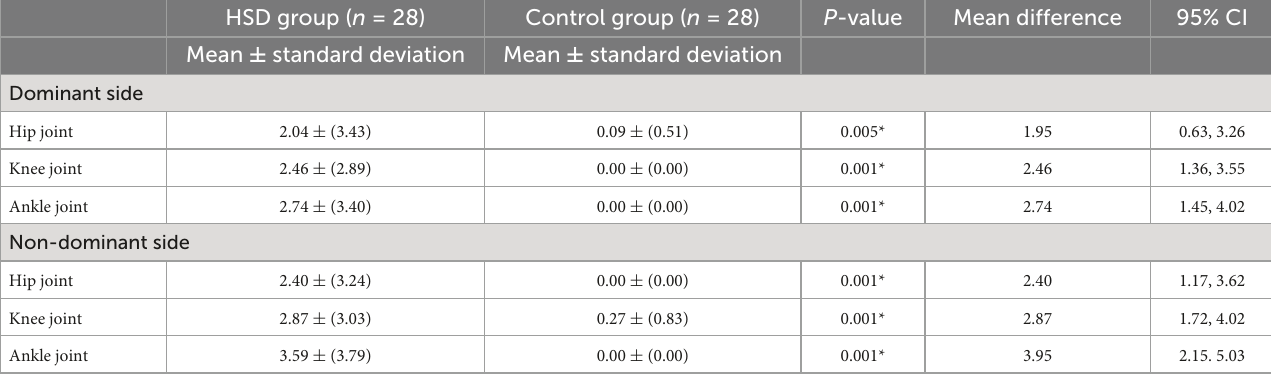
TABLE 3 The intensity of joint pain (measured with visual analogue scales) for the hypermobility spectrum disorders (HSD) group compared to the control group. HSD group ( n =